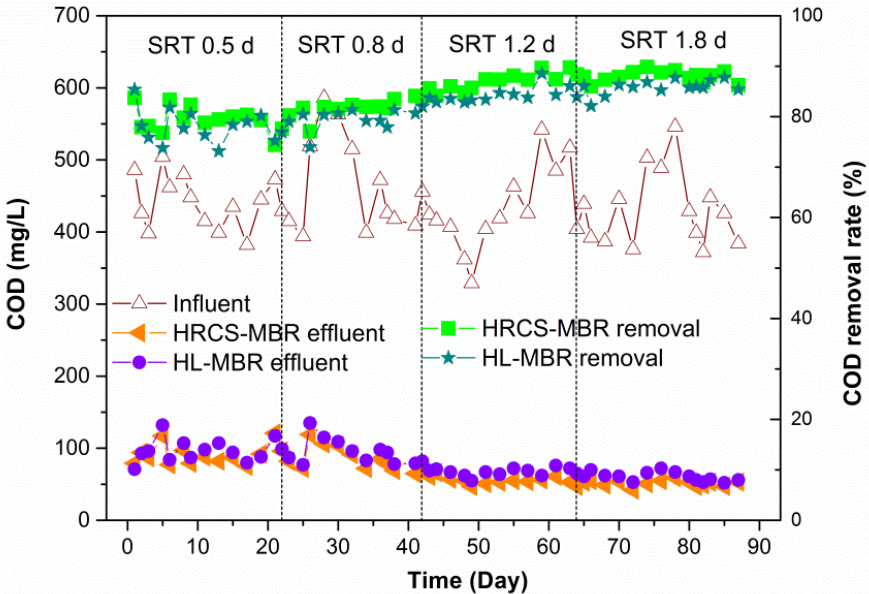
Figure 2. Evolutions of total chemical oxygen demand (COD) removal effect for two MBRs during different SRT conditions.